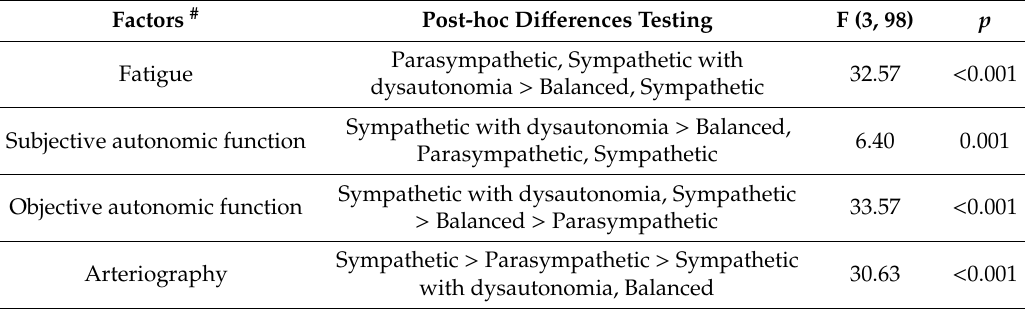
Figure 1. The four CFS profiles comprising four factors, n = 102. Post-hoc di ff erences were tested by Student-Newman-Keuls. ANS, Autonomic Nervous System. Table 8. Di ff erences in factors between subgroups, n =